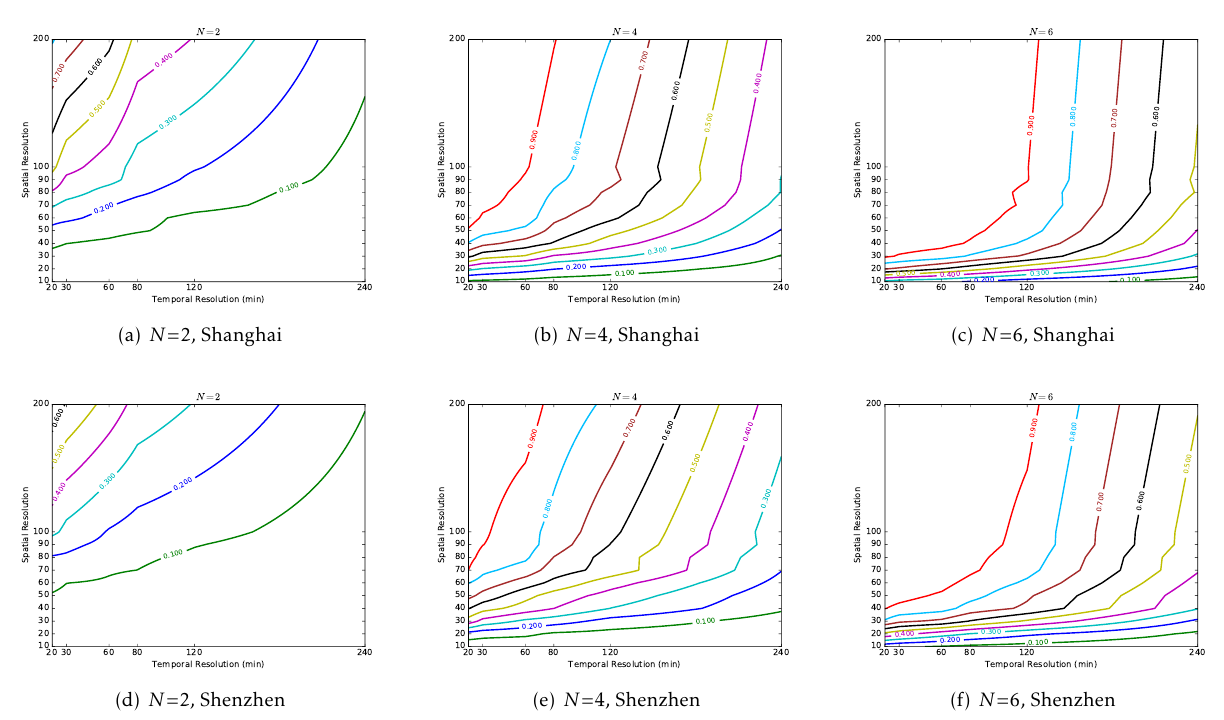
Figure 5. Contour Map of Uniqueness of Traces of Two